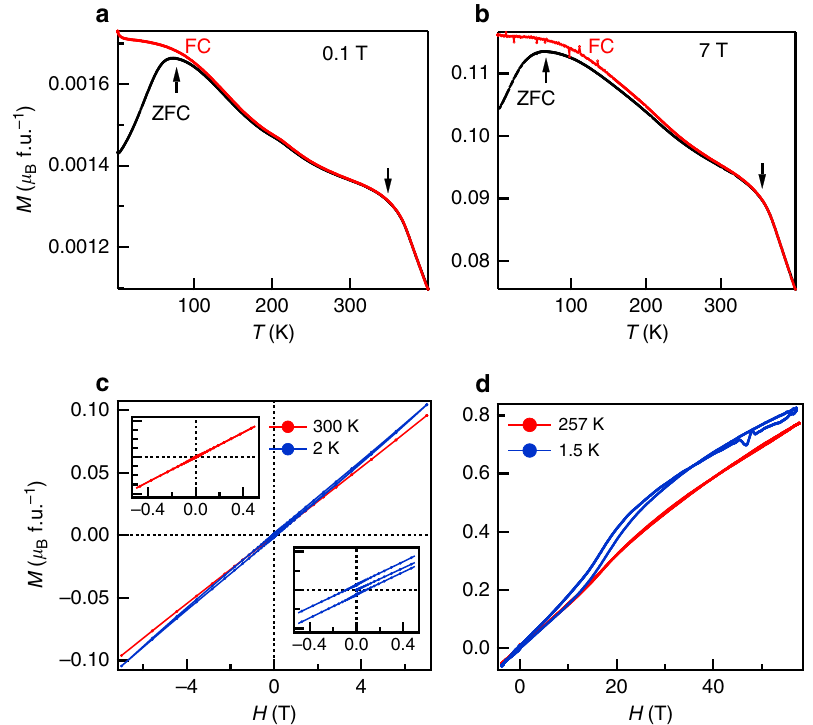
Figure 2 | Magnetization of Pt 2 MnGa. Temperature-dependent magnetization M ( T ) (black line—ZFC, red line—FC regime) at ( a ) 0.01T and ( b ) 7T. Field-dependent magnetization M ( H ) hysteresis loops ( c ) up to 7Tat 2 (blue) and 300K (red) and ( d ) up to 60Tat 1.5K (blue) and 257K (red). The insets in ( c ) show the zoomed M ( H ) behaviour at low magnetic field for 2 (blue) and 300K (red).